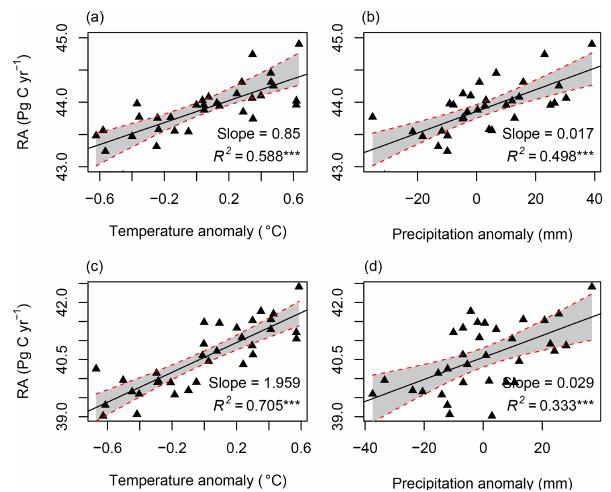
Figure 8. The correlation between RA and temperature and pre- cipitation: (a, b) for RF-RA and (c, d) for Hashimoto2015-RA. The anomaly was calculated as the difference between temperature or precipitation of corresponding year and the mean of 1980–2012. *** means significant level at